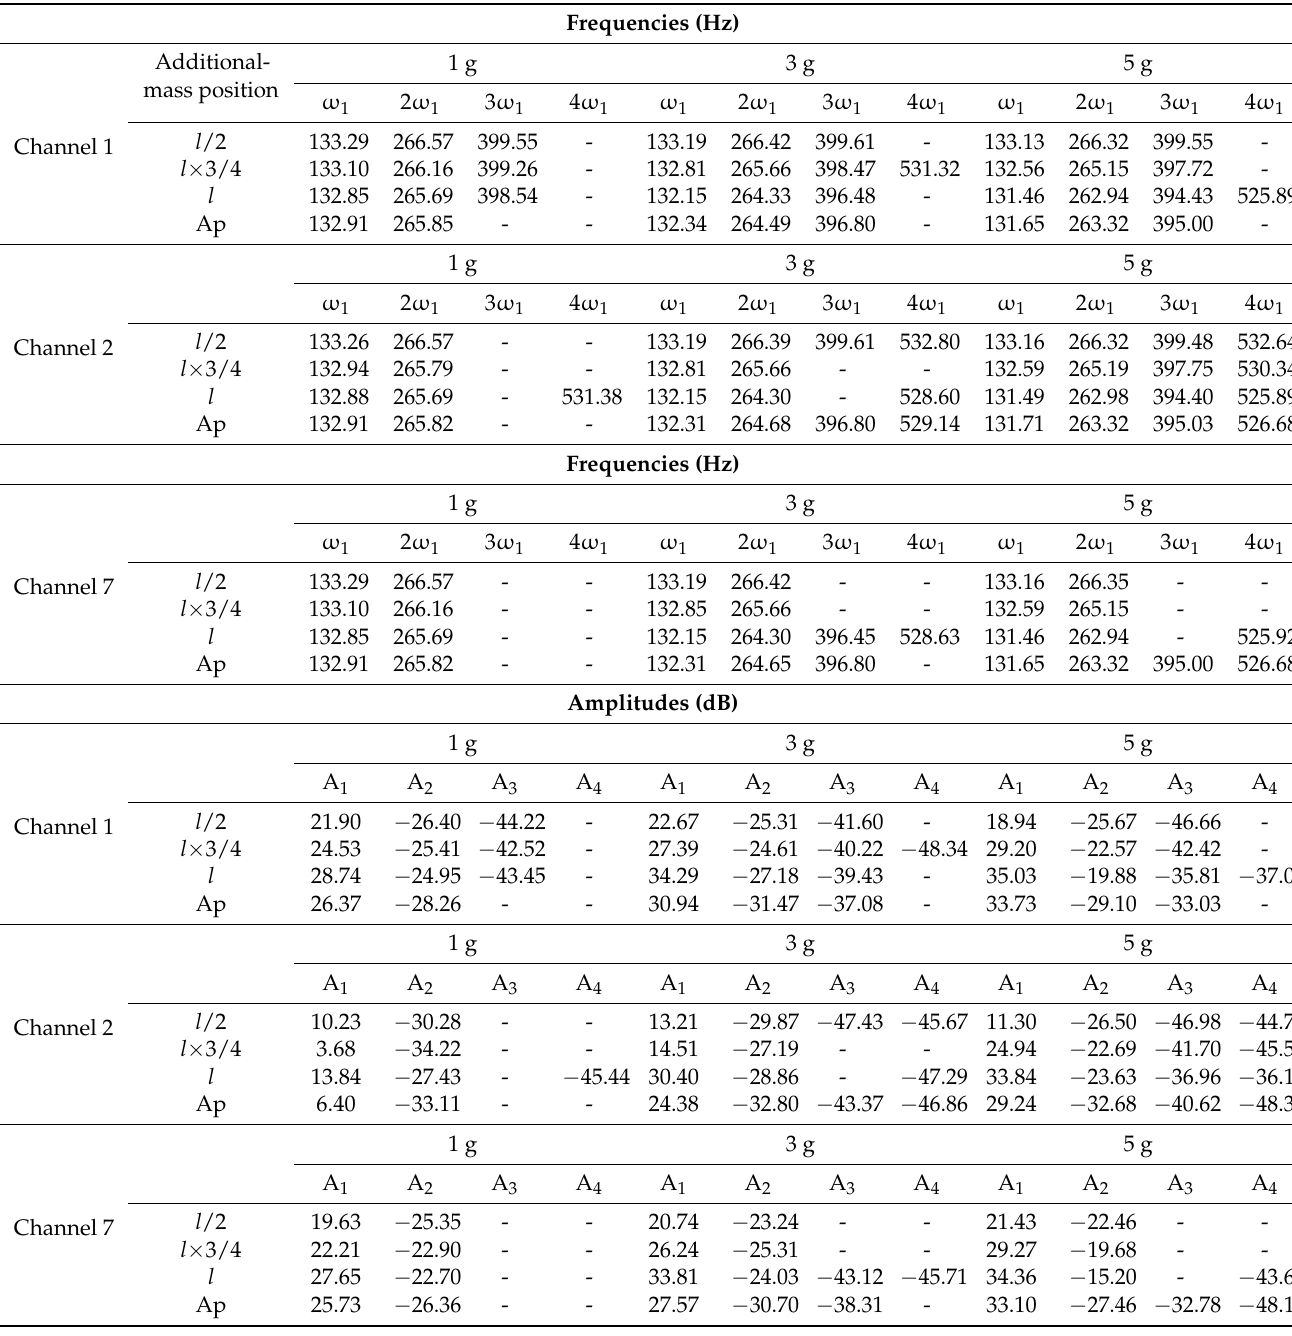
Table 6. Frequencies and